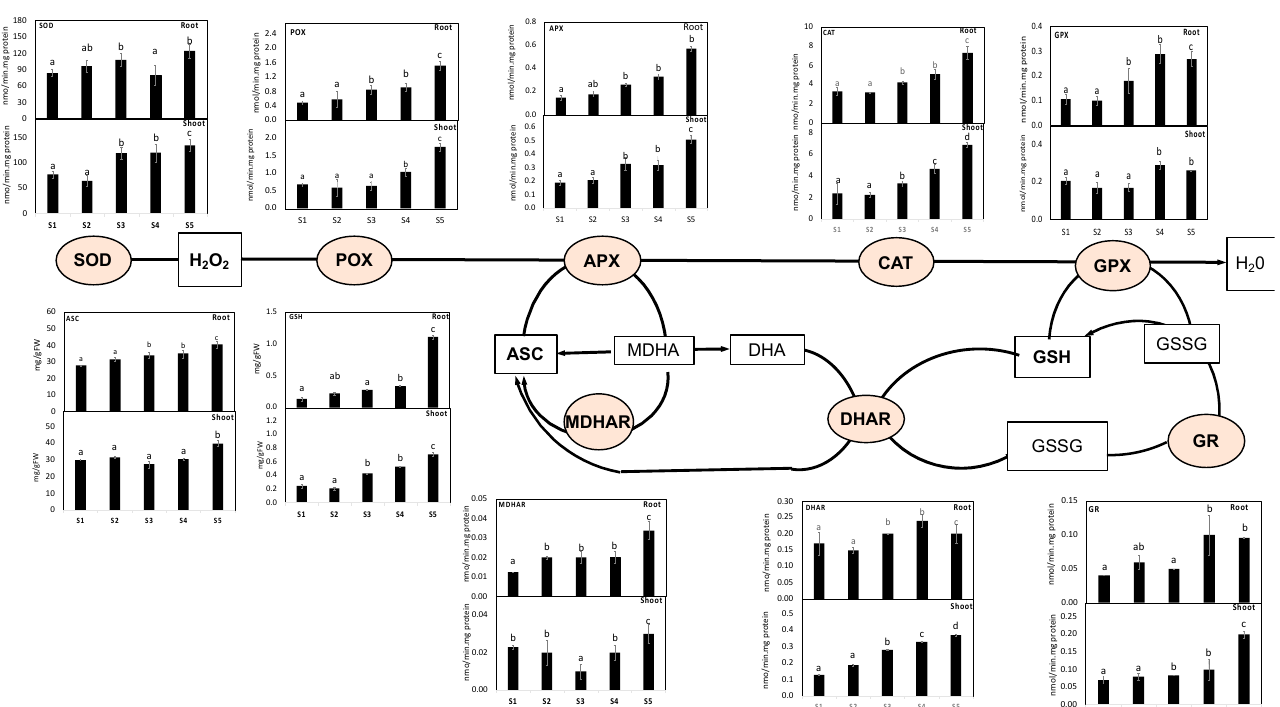
Figure 4. The impacts of soil pollution on ASC-GSH cycle-related metabolites and enzymes in the shoots and roots of S. portulacastrum strum grown in different control sites (site 5) and contaminated sites (site 1–4). Data are mean values ± SD ( n = 4). Different letters indicate a statistically significant difference between means of the same plant species at a significance level at least ( p ≤ 0.05).